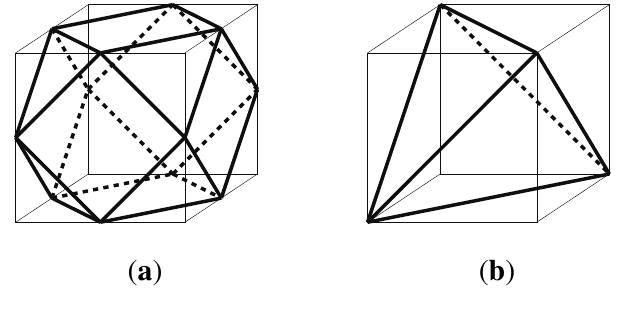
Figure 1. ( a ) A cuboctahedron; ( b ) a regular tetrahedron—the best-known imaginary